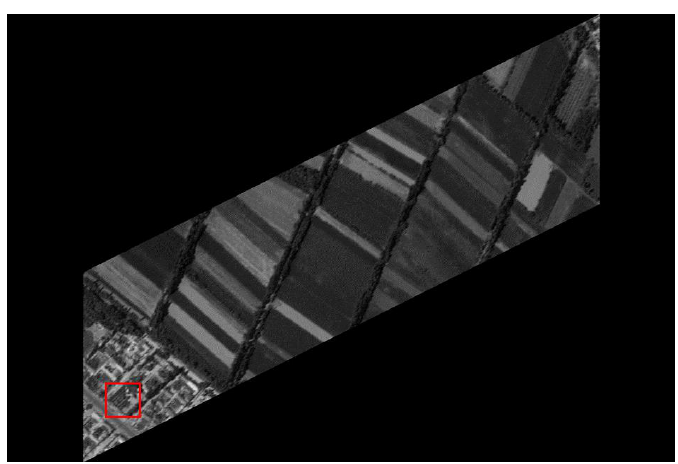
Figure 11. The farmland remote-sensing image experimental results: super-resolution images, the selected area is the crops and houses in Xinjiang, China. Sensors 2020 , 20 , x